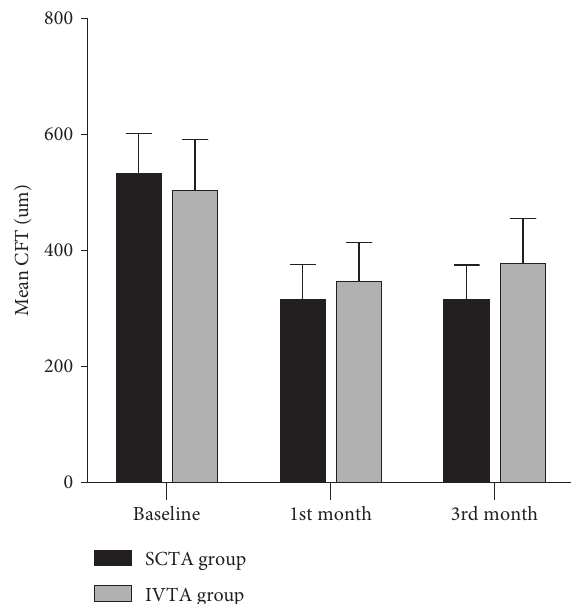
Figure 2: Central foveal thickness in both groups at baseline, 1, and 3 months.